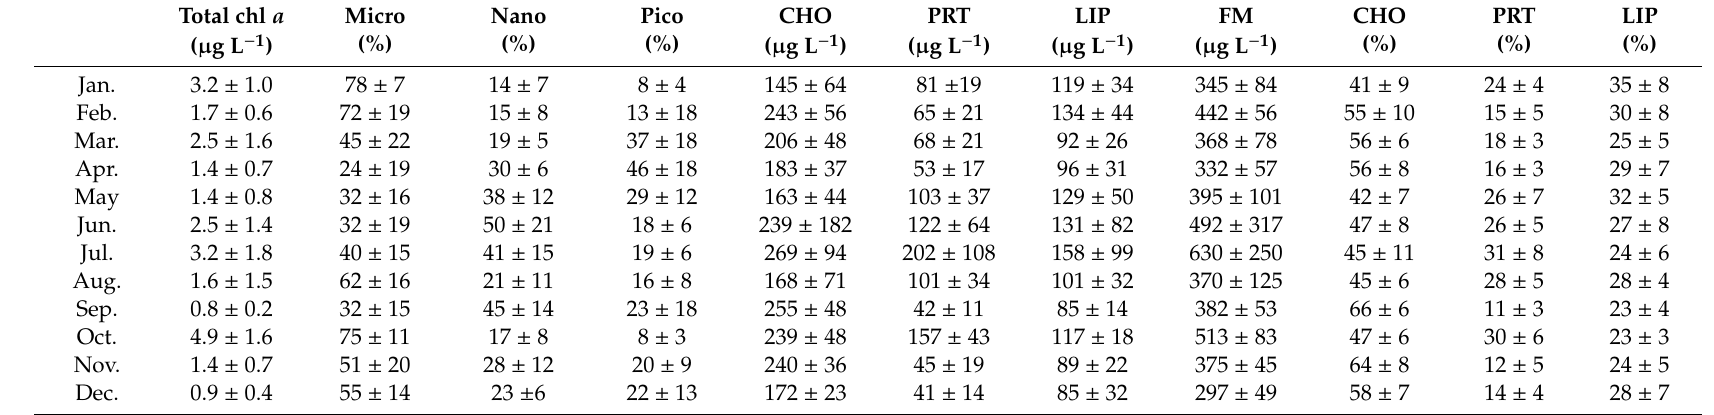
Table 2. Monthly averaged compositions of di ff erent sized chlorophyll a concentrations and biochemical concentrations and compositions of POM averaged from seven di ff erent stations in Jaran Bay. Total chl a Micro Nano Pico CHO PRT LIP FM CHO PRT LIP ( µ g L − 1 ) (%) (%) (%) ( µ g L − 1 ) ( µ g L − 1 ) ( µ g L − 1 )